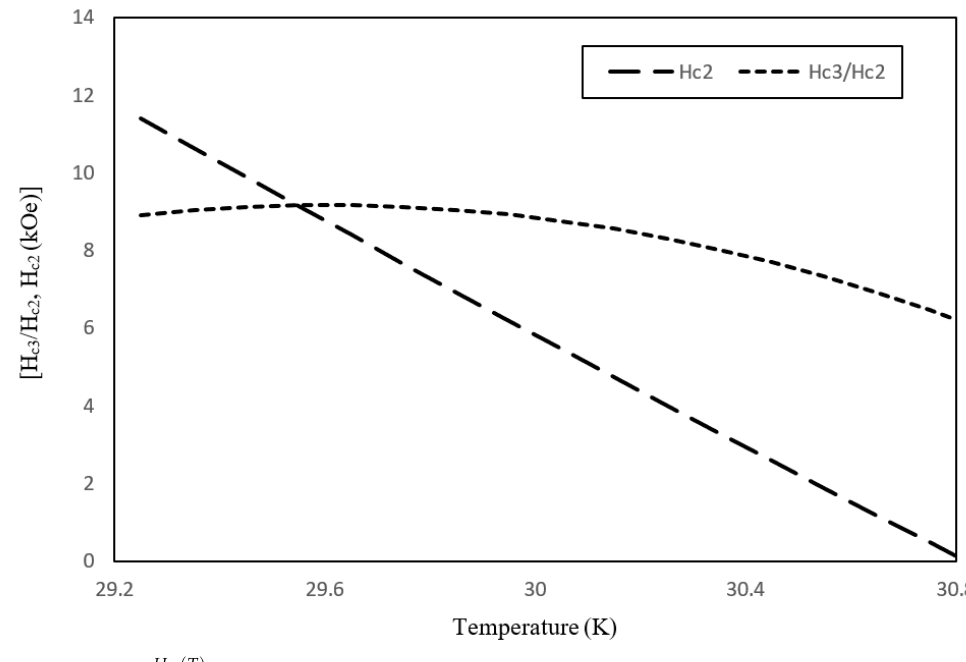
Equations (18) and (19) were used to calculate the curve with T c = 30.8 K, and the ( T ) behavior of H c 3 and H c 2 ( T ) versus temperature is shown in Figure 1. Here, the upper H c 2 ( T ) critical magnetic field decreases as the temperature increases and reaches zero at a critical temperature. The zero-temperature upper critical of 416.37 kOe was found to be in the range from 193 kOe to 60 T of the rough estimation for Ref. [22] and well extrapolated in a wide range of temperatures for Ref. [48].